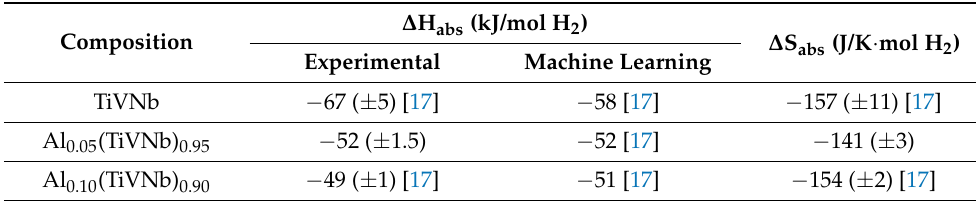
Table 4. Thermodynamic properties of hydride formation in Al 0.05 (TiVNb) 0.95 together with already reported experimental and ML predicted values for TiVNb and Al 0.10 (TiVNb) 0.90 [17].